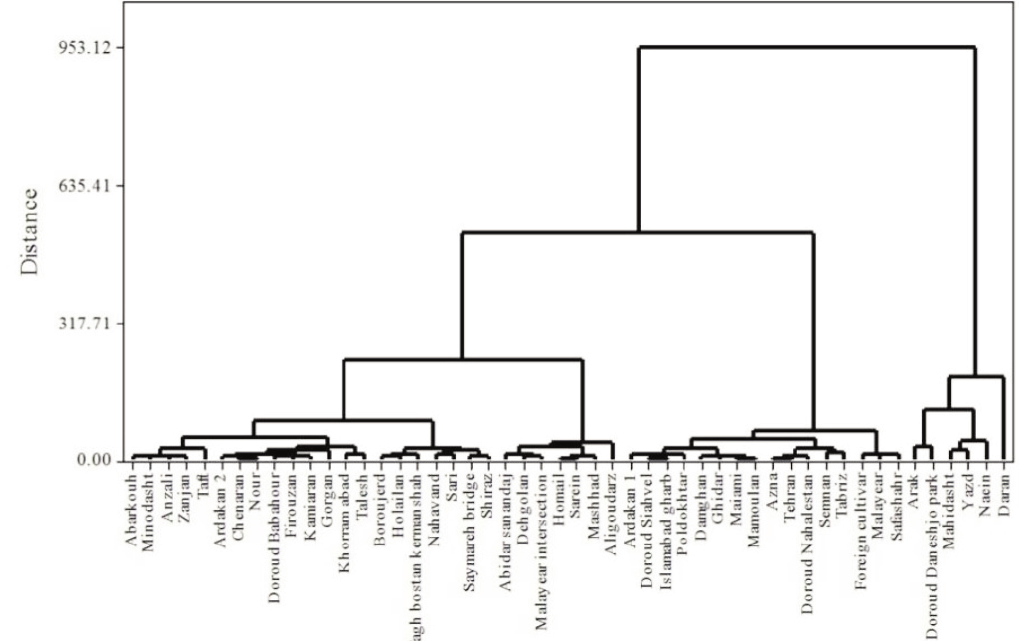
Fig. 4 - Dendrogram of the physiological relationships between 50 accessions of common bermudagrass and control cultivar after cold stress at -7.5/-12°C day/night cycles.